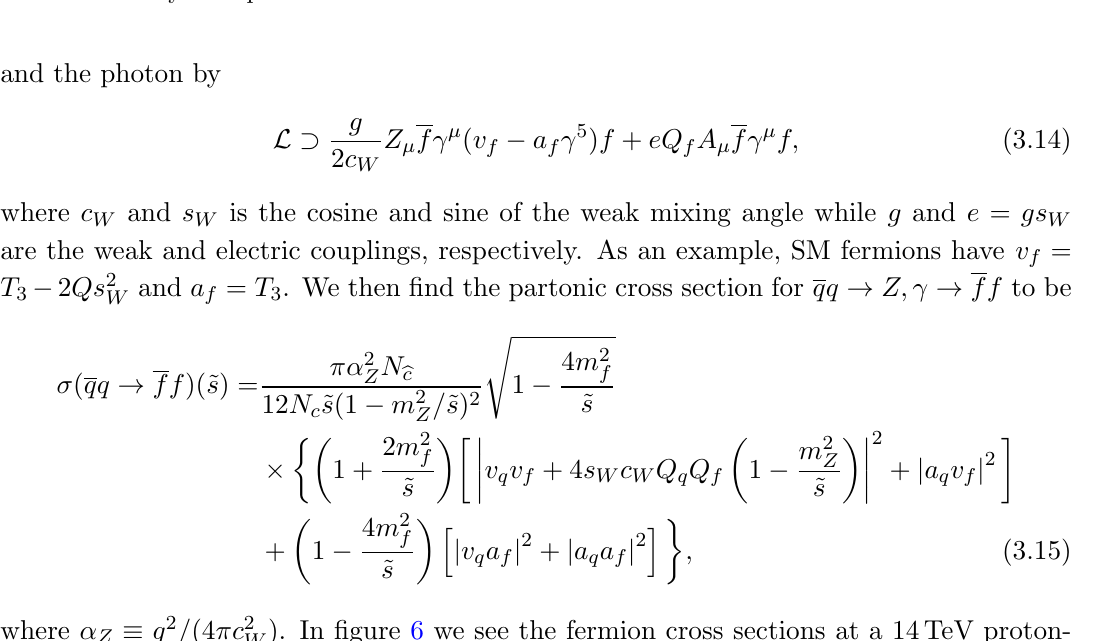
T (cid:0) is given by the dotted green b